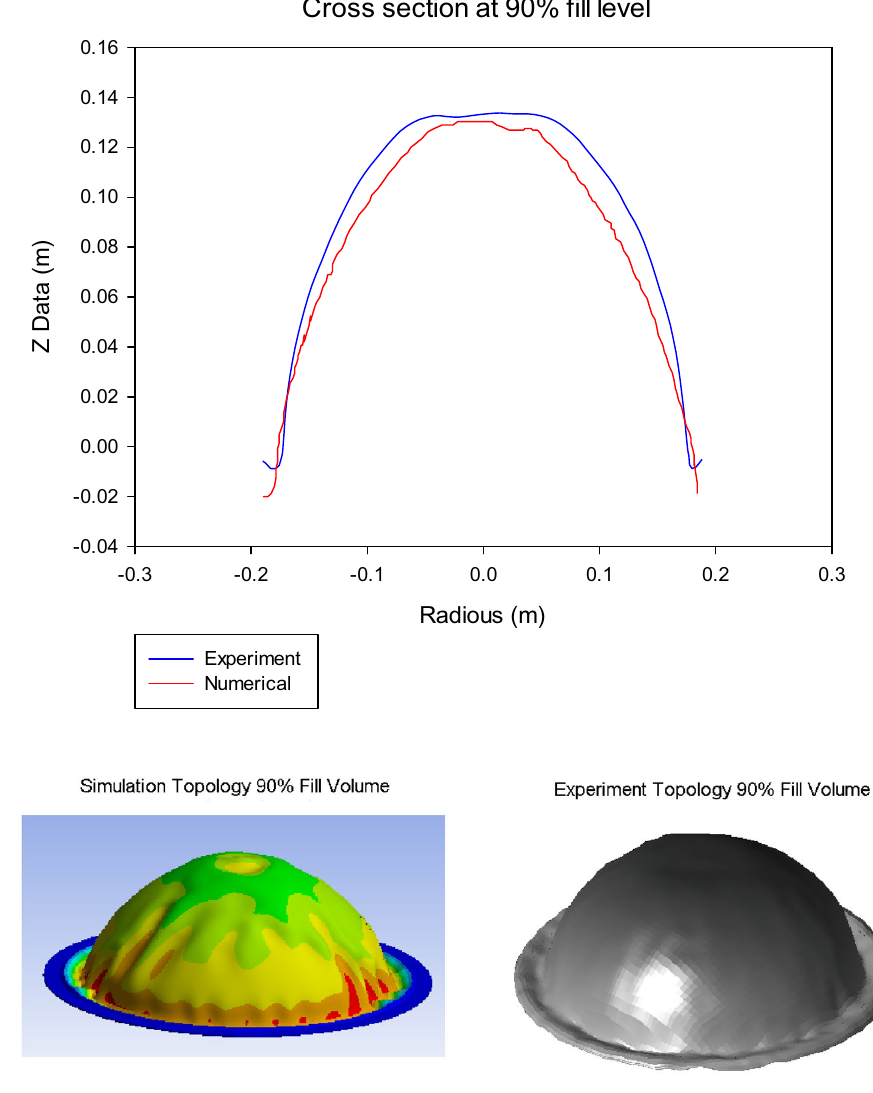
Cross section at 90% fill